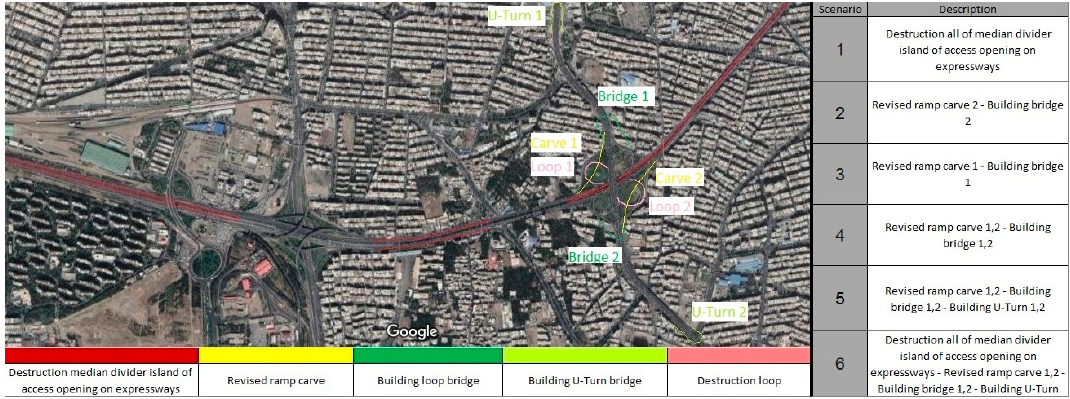
Figure 2. Six proposed scenarios.